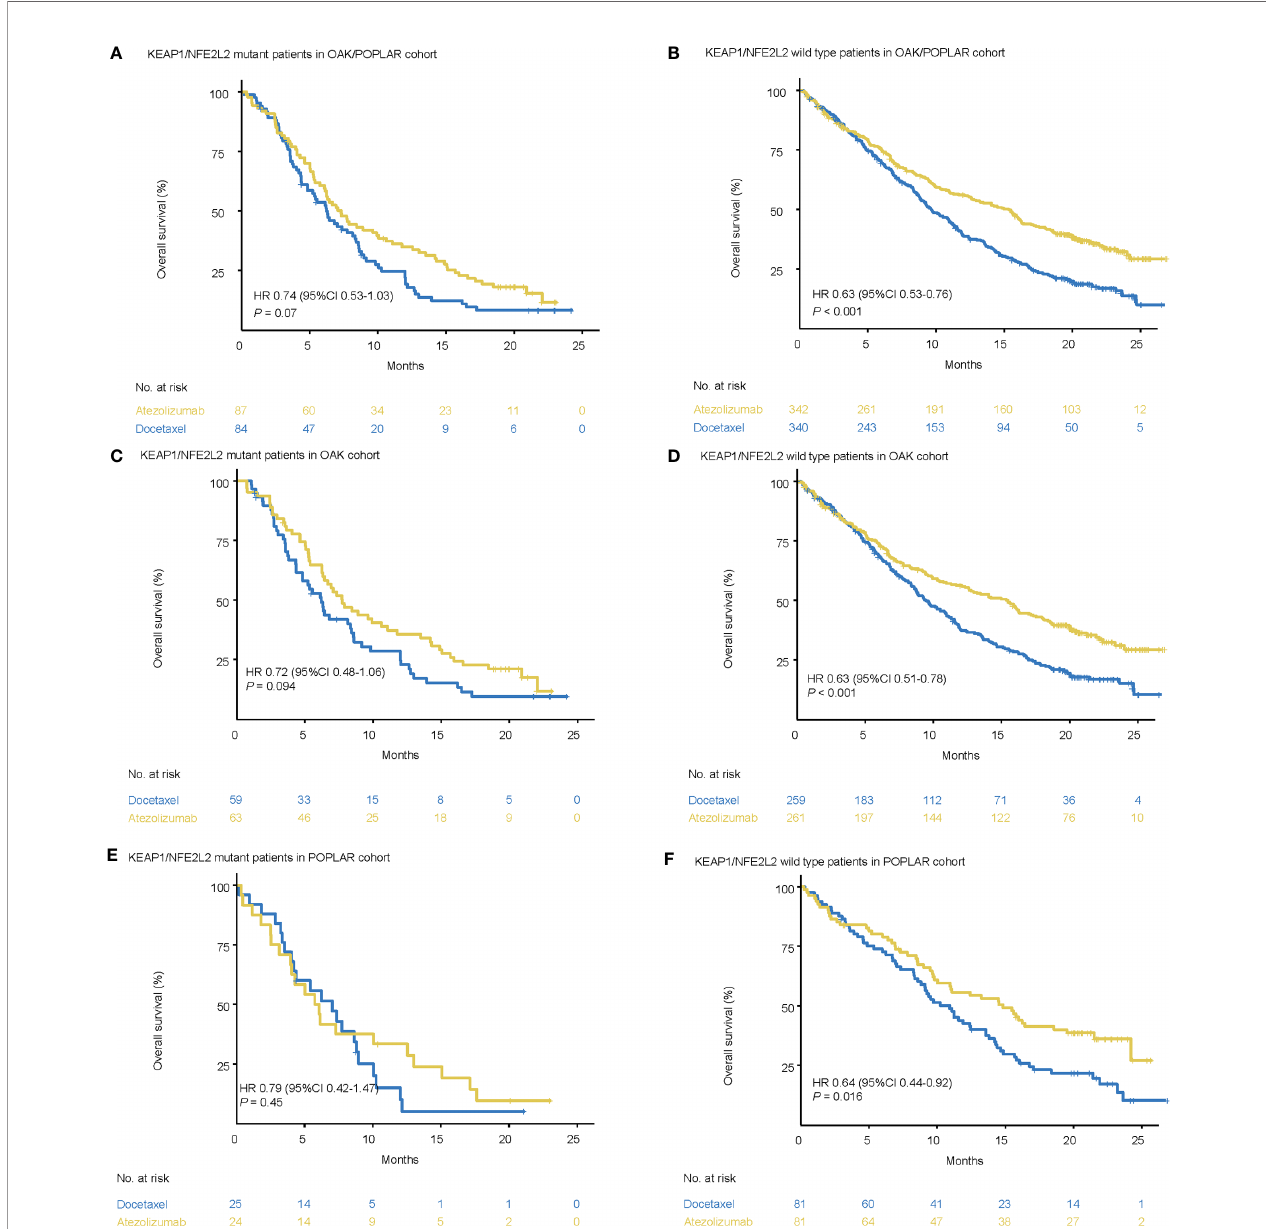
FIGURE 2 | Survival analyses in the OAK/POPLAR cohorts. (A) Kaplan – Meier curves of overall survival (OS) in the patients with KEAP1/NFE2L2 mutations who received atezolizumab and docetaxel in the OAK/POPLAR cohorts. (B) Kaplan – Meier curves of OS in the patients without KEAP1/NFE2L2 mutations who received atezolizumab and docetaxel in the OAK/POPLAR cohorts. (C) Kaplan – Meier curves of OS in the patients with KEAP1/NFE2L2 mutations who received atezolizumab and docetaxel in the OAK cohort. (D) Kaplan – Meier curves of OS in the patients without KEAP1/NFE2L2 mutations who received atezolizumab and docetaxel in the OAK cohort. (E) Kaplan – Meier curves of OS in the patients with KEAP1/NFE2L2 mutations who received atezolizumab and docetaxel in the POPLAR cohort. (F) Kaplan – Meier curves of the OS in the patients without KEAP1/NFE2L2 mutations who received atezolizumab and docetaxel in the POPLAR